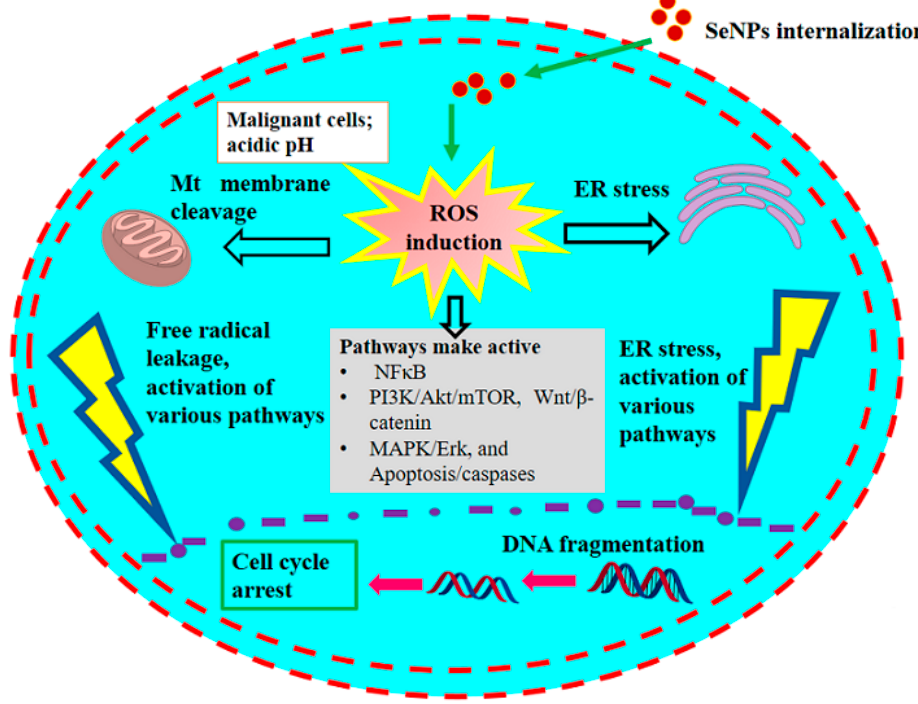
Figure 3. The anticancer mechanism of SeNPs in cancerous cells. Updated as from Khurana et al.